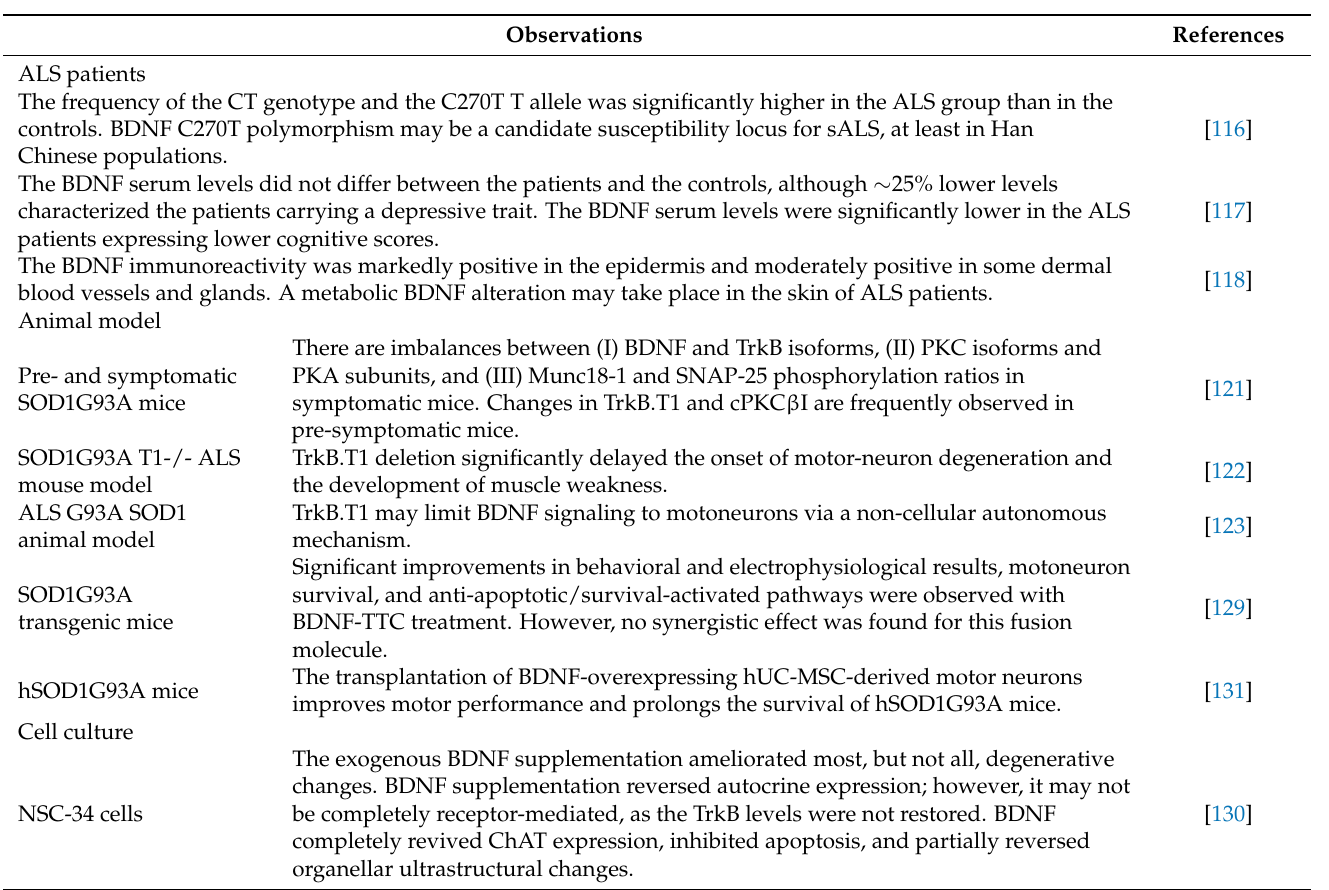
Table 4. Role of BDNF in amyotrophic lateral